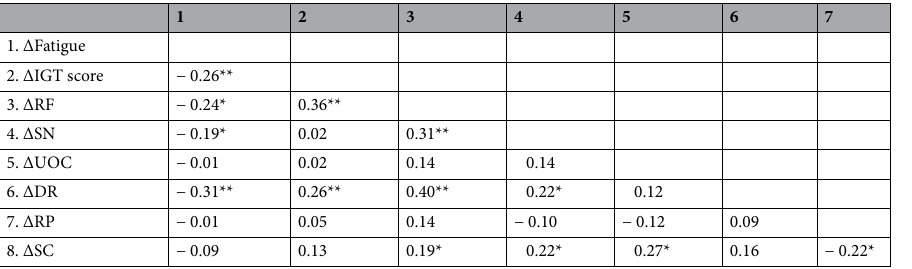
Table 2. Correlation analysis of the changes in fatigue, IGT scores, and A-DMC after night shift (n = 107). IGT Iowa Gambling Task, RF resistance to framing, SC resistance to sunk costs, RP consistency in risk perception,